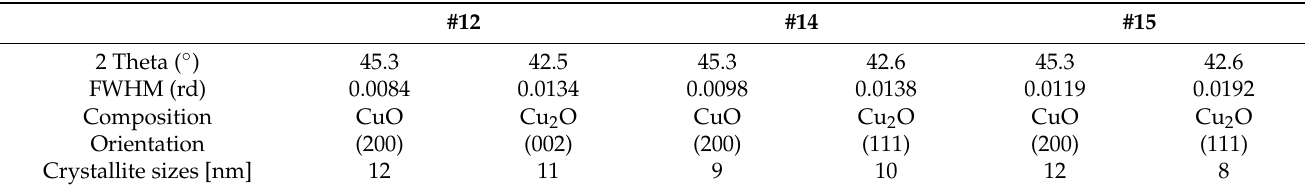
Table 2. Bragg angle 2 Theta, FWHM, composition, crystallite sizes for copper